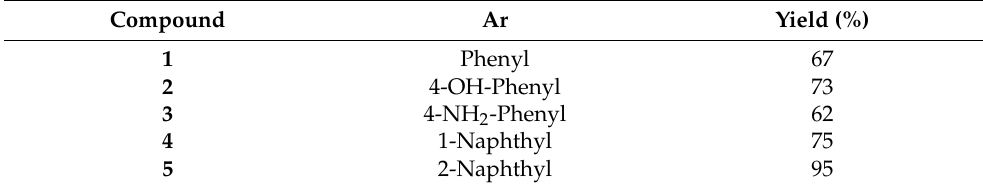
Table 1. Substitution patterns in Type I chalcones and the reaction yield.